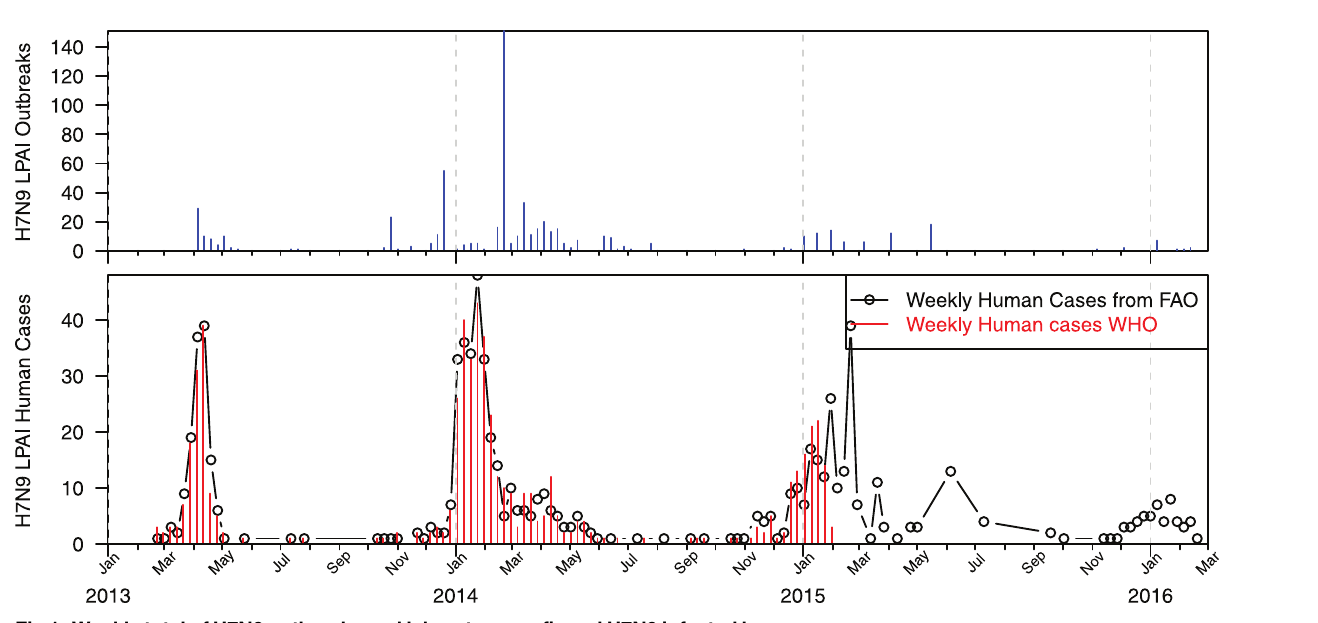
Fig 1. Weekly total of H7N9 outbreaks and laboratory confirmed H7N9 infected human cases.